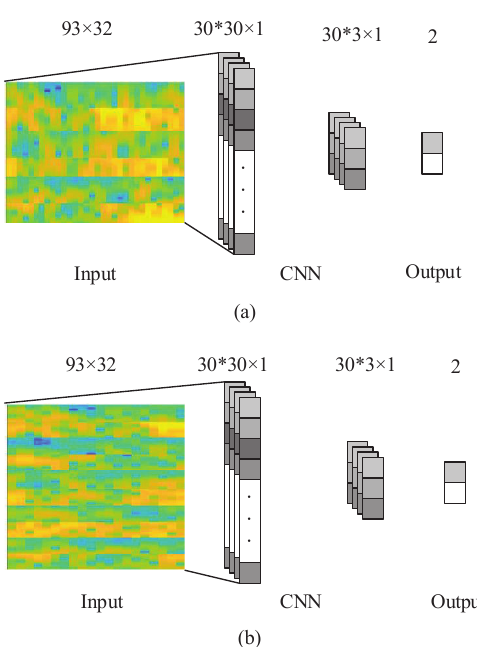
Figure 3. The proposed CNN network with 3 electrodes and 5 electrodes. ( a ) is the CNN network with 3 electrodes; ( b ) is the CNN network with 5